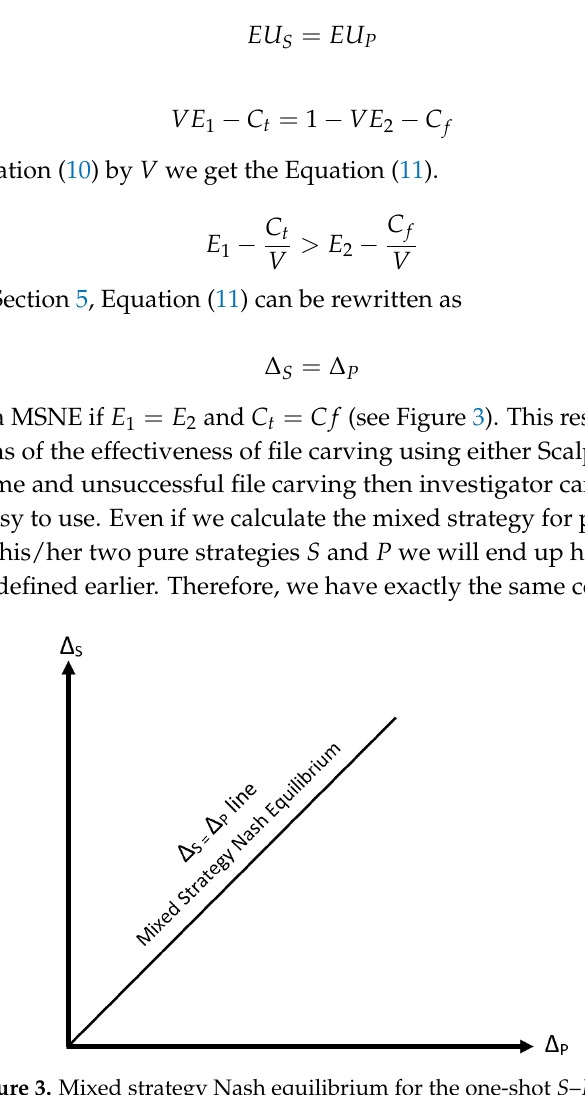
Figure 3. Mixed strategy Nash equilibrium for the one-shot S – P